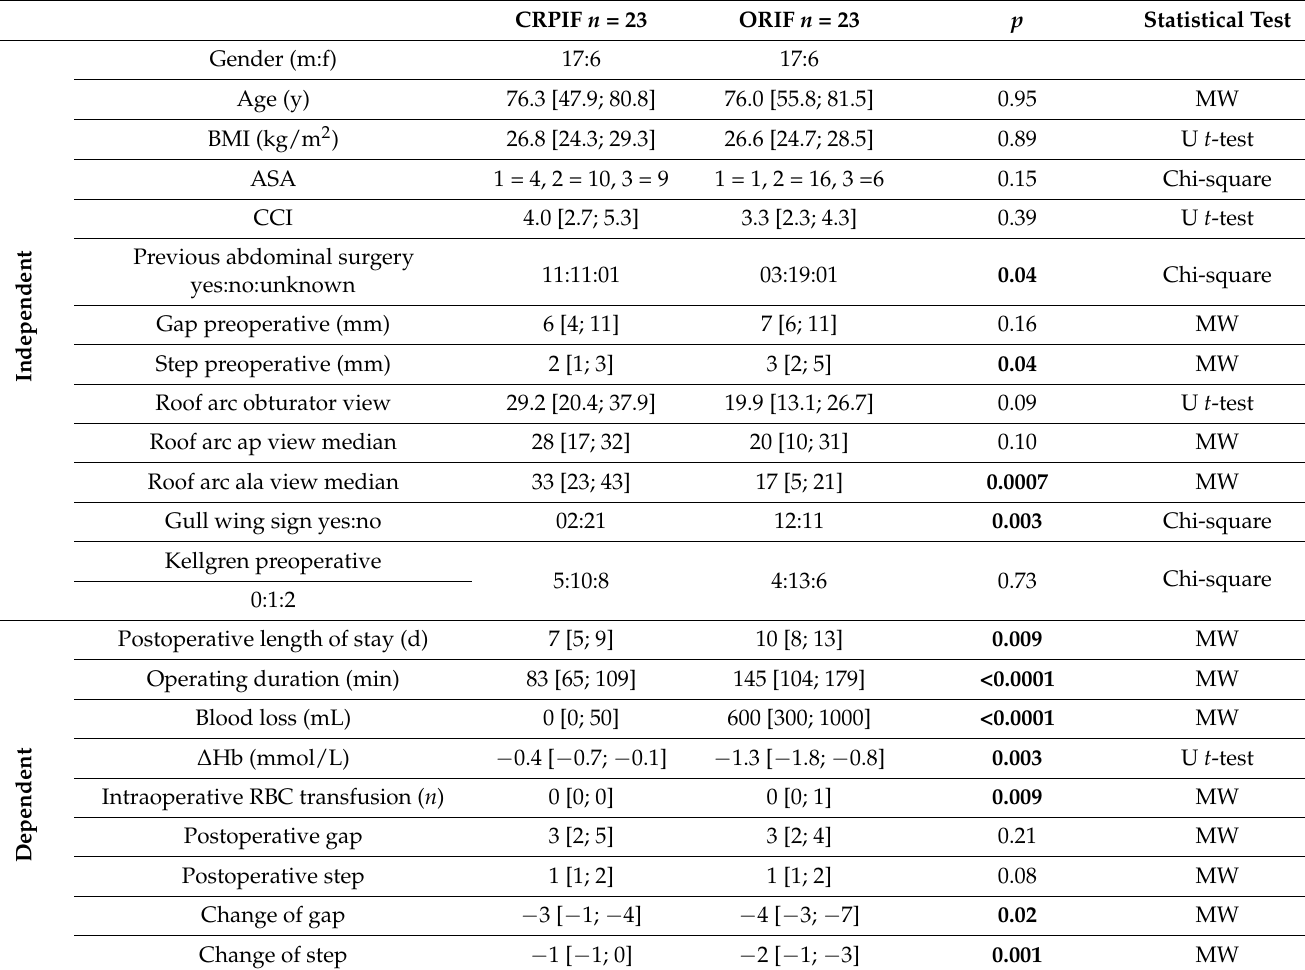
Table 1. Results of the in-hospital stay for CRPIF and ORIF comparing surgery-dependent and -independent factors. Gaussian-distributed data (BMI, CCI, roof arc obturator view, and ∆ Hb (mmol/L)) are presented as mean [95% CI]. Non-Gaussian-distributed data (age; gap, step, and their change; roof arc obturator, ap, and ala views; postoperative length of stay; operation duration; blood loss; and intraoperative RBC transfusion) are presented as median [IQR25-75]. Open reduction and internal fixation, ORIF; closed reduction and percutaneous internal fixation, CRPIF; confidence interval, CI; interquartile range 25–75%, IQR25-75; male, m; female, f; years, y; American Society of Anesthesiologists grading, ASA; Charlson Comorbidity Index, CCI; days, d; minutes, min; difference between pre- and postoperative hemoglobin concentration, ∆ Hb; red blood cell, RBC; Mann–Whitney U test, MW; unpaired test, U t -test; chi-square test, Chi-square. CRPIF n = 23 ORIF n = 23 p Statistical Test